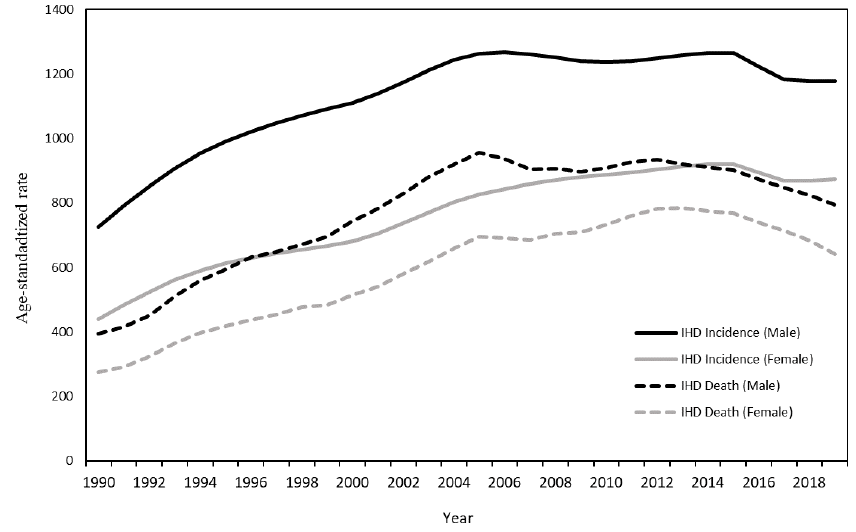
Figure 2. The trend of the age-standardized rate of death from and incidence of ischemic heart disease between 1990 and 2019 in Uzbekistan.